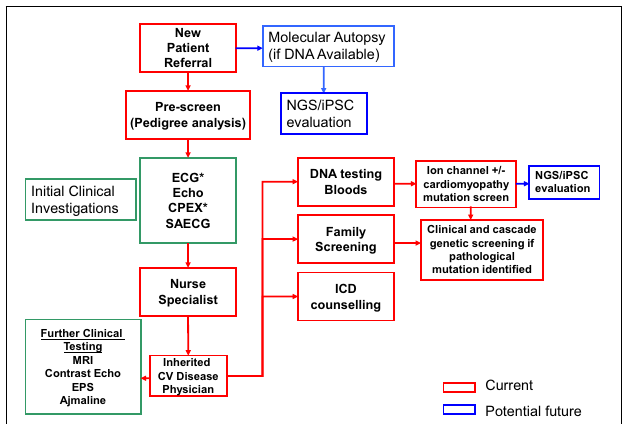
FIGURE 6 | Overview of the different strategies in the management of a SADS family. Abbreviations include: EPS, electrophysiological study; Echo, echocardiogram; CPEX, cardiopulmonary exercise testing; SAECG, signal averaged ECG; NGS, next-generation